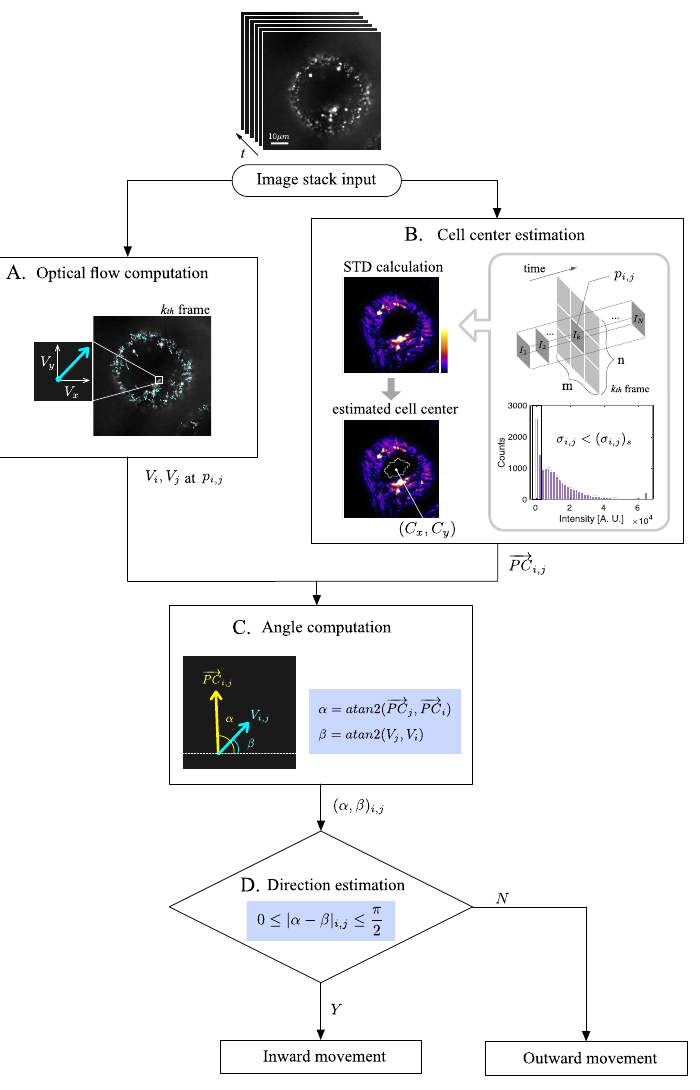
Figure 3. Workflow for estimating the direction of intracellular vesicle using optical flow and cell center estimation. ( A ) Optical flow computation based on Lucas-Kanade scheme [33] for the image stack. For simplicity of notation, let V i , V j represent the acquired optical flow at the pixel p i , j . ( B ) Geometric cell center ( C x , C y ) as the mean coordinates of the area where intensity STD, −→ PC i , j is the vector from p i , j to ( C x , C y ) . σ i , j , is smaller than one STD of the STD distribution, ( σ i , j ) s . −→ PC i , j and V i , j . ( C ) Evaluation of angles α and β computed by four-quadrant inverse tangent of −→ −→ −→ PC i indicates the x -component and PC j refers to the y -component of the vector PC i , j , respectively. ( D ) Comparison of α and β to estimate the direction of vesicle with respect to the cell